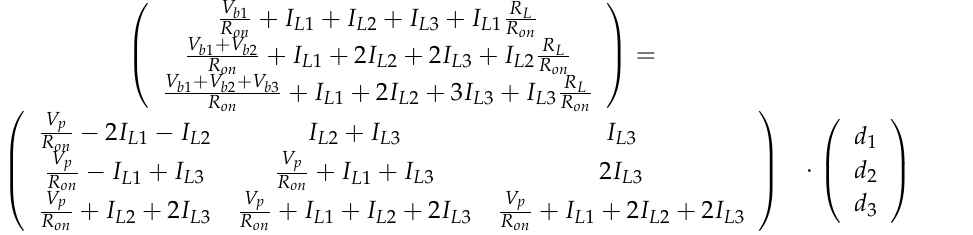
Figure 2. Control signals of MOSFET.